Question: Express in one sentence what the figure is showing.
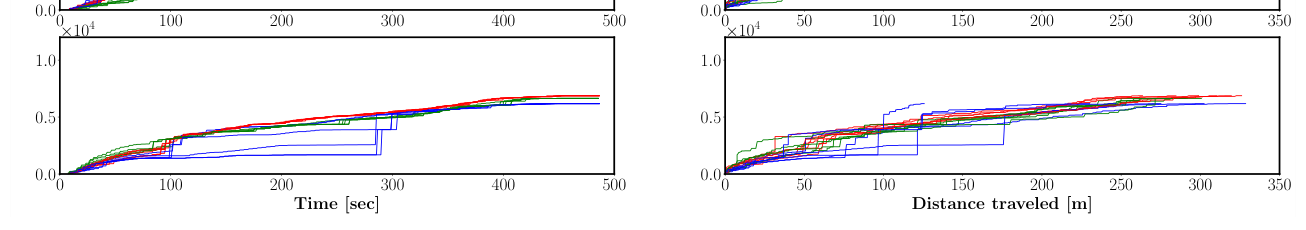
Answer: quantifies the coverage achieved by each network topology and planning parameter set. For Collaborative and Egocentric planning configurations, Full network configura- tion leads to faster coverage while traveling less distance compared to Hierarchical and Ring topologies. This is ex- pected since Full is the only network topology that allows one-hop exchange of information between any pair of robots. On the other hand, the network configuration does not play a significant role for Frontier exploration in terms of total covered area, since robots usually choose a frontier that is nearby their current position, and do not utilize information coming from their peers’ local maps. The most interesting takeaway from Fig. 10 is the similar performance of Col- laborative planning with Hierarchical and Ring topologies, compared to Egocentric planning with Full topology. This observation suggests that effective coordination among agents via Collaborative planning can alleviate the longe